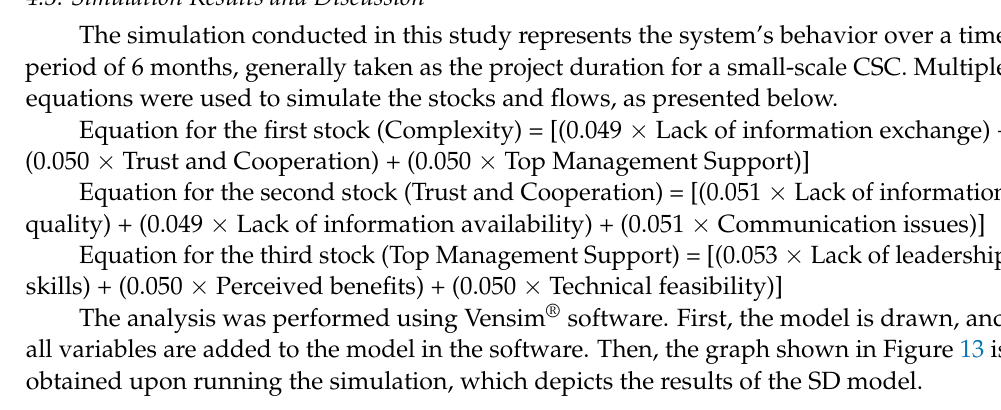
Figure 12. System dynamics model for managing information complexity.